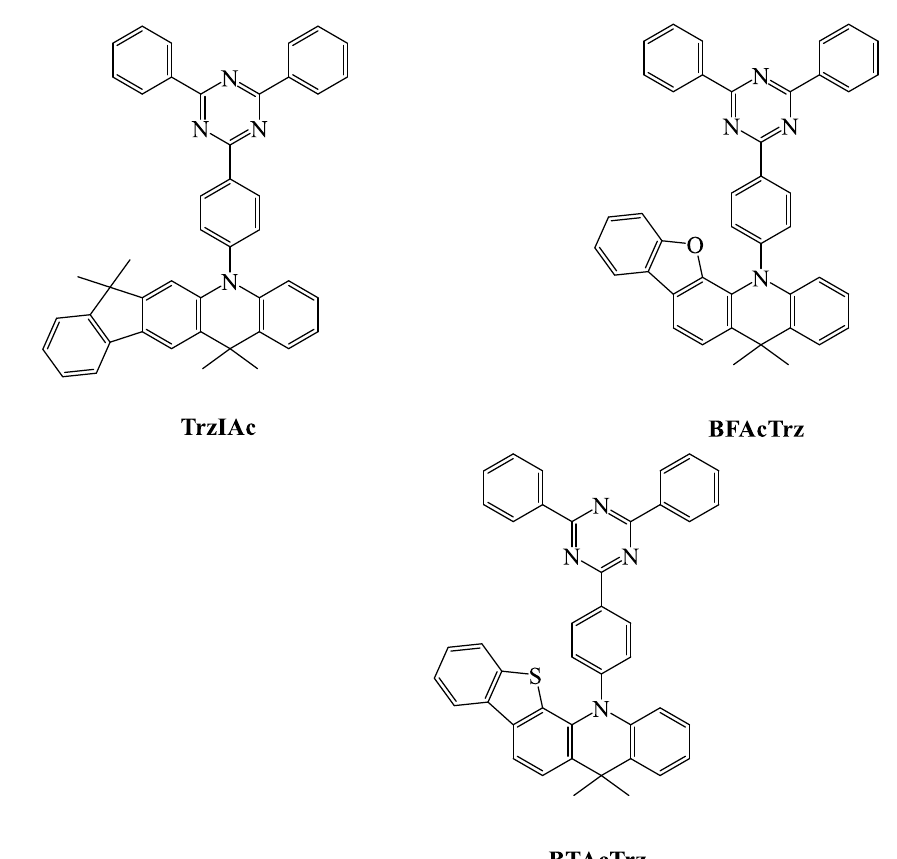
Figure 3. Molecular structures of triazine acceptors with acridine-based rigid donor moieties.